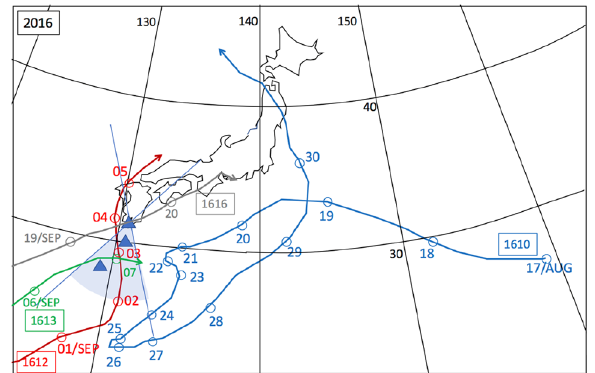
Figure 2. Meteorological history of tropical cyclones T-1610, T-1612, T-1613, and T-1616 48 . Black numbers next to the coordinate grid indicate the latitude and longitude. Blue, red, green, and grey numbers indicate the date of the positions of T-1610, T-1612, T-1613, and T-1616, respectively. Triangular symbols indicate the atmospheric pressure gauge stations (from north to south, Kagoshima, Yakushima and Naze stations). The azimuthal viewing angle of the Kagoshima Muograph (KM) is also indicated (shaded area). HKMT drew the map with Microsoft PowerPoint software and HKMT drew the image with Microsoft PowerPoint software and holds the copyright.